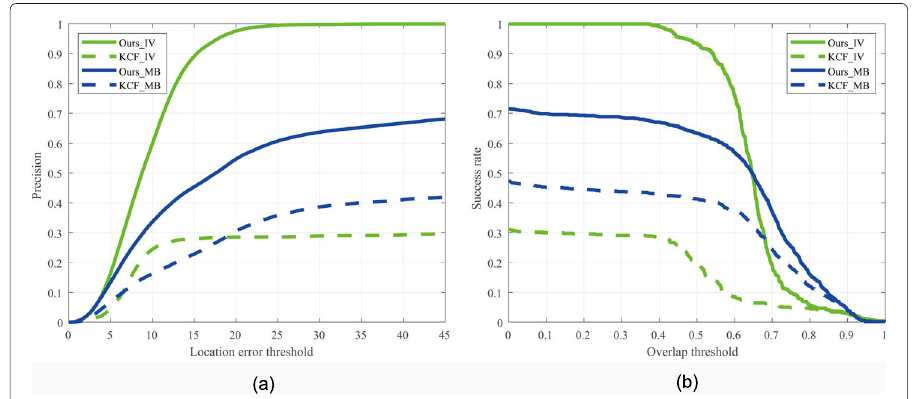
Experiment 1 The object in the four video sequences is tracked by an unimproved KCF